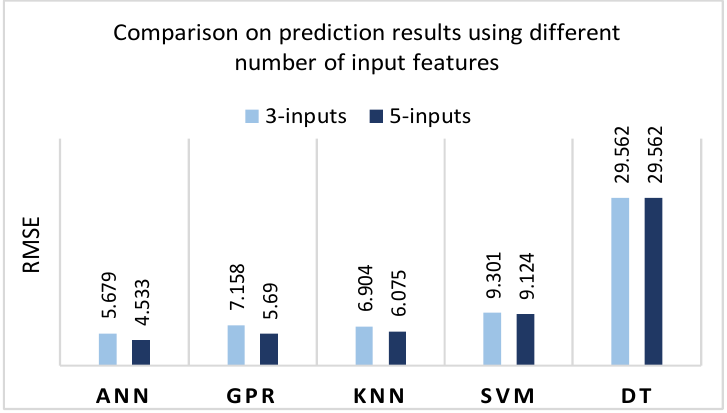
Figure 21. Comparison of prediction results using a different number of input features: five input features (forming depth, step depth, sheet thickness, VFC dry friction, VFC vibro excitation) and three inputs (forming depth, VFC dry friction, VFC vibro excitation).